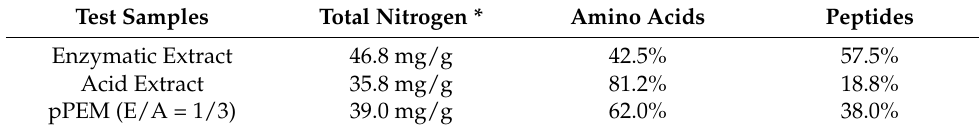
Figure 1. Raw material properties in the process steps. Table 1. Nitrogen, amino acid, and peptide amounts in the pPEM formulation.